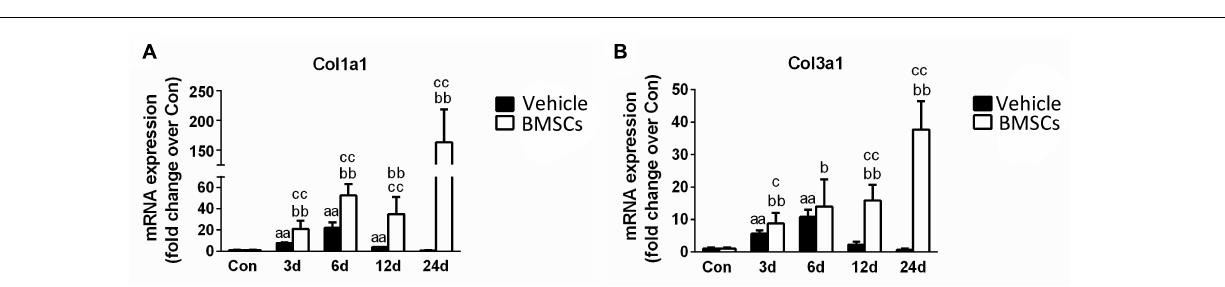
FIGURE 5 | The effects of BMSCs treatment on the expression of collagen. (A) The expression of mRNA of Col1a1. (B) The expression of mRNA of Col3a1. Vehicle, muscle contusion and vehicle treated group; BMSCs, muscle contusion and BMSCs treated group. Data are means ± S.D., n = 8; a Significant difference from Control, P < 0.05; aa P < 0.01. b Significant difference from control, P < 0.05; bb P < 0.01. c Significant difference from the same time points of group vehicle, c P < 0.05; cc P < 0.01. The transplantation of BMSCs significantly increased the expression of collagen I and III mRNA as compared with the vehicle treated mice after muscle